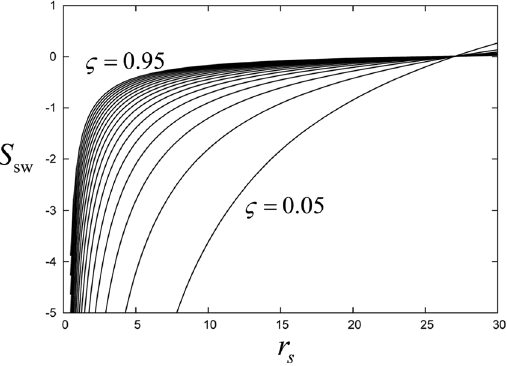
Figure 5. Spin-wave stiffness of the 2DEG, obtained with the ALDA, for various values of the spin polarization ζ between 0.05 and